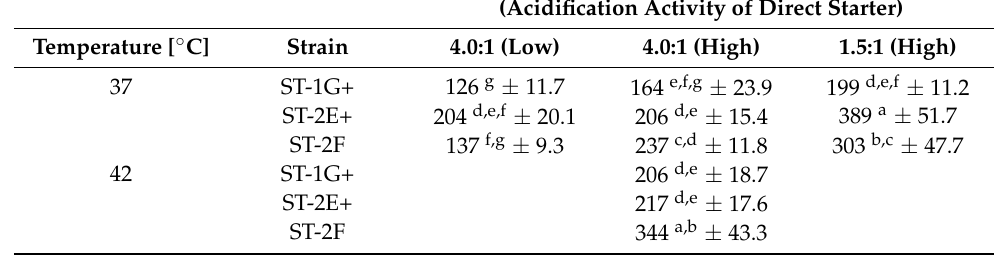
1 Arithmetic mean ± standard deviation. Means with different letters are significantly different ( p < Table 2. Hysteresis area (Pa/s) of stirred gel after 3 d of cold storage ( n = 4). Gels were produced from base milk with casein:whey protein ratio of 4.0:1 or 1.5:1 by inoculation with low- or high- activity starters and fermentation at a fermentation temperature of 37 °C or 42 °C 1 .